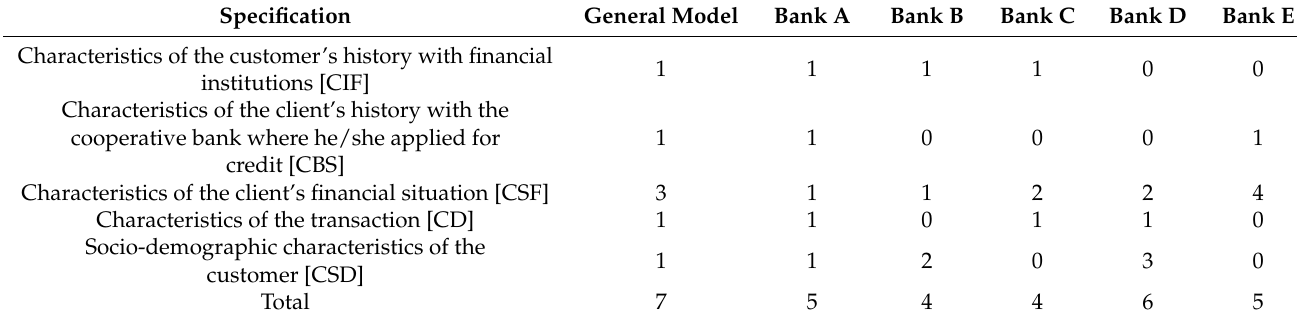
Table 10. Summary of variables in estimated credit risk logit regression models in analyzed banks by feature category. Specification General Model Bank A Bank B Bank C Bank D Bank